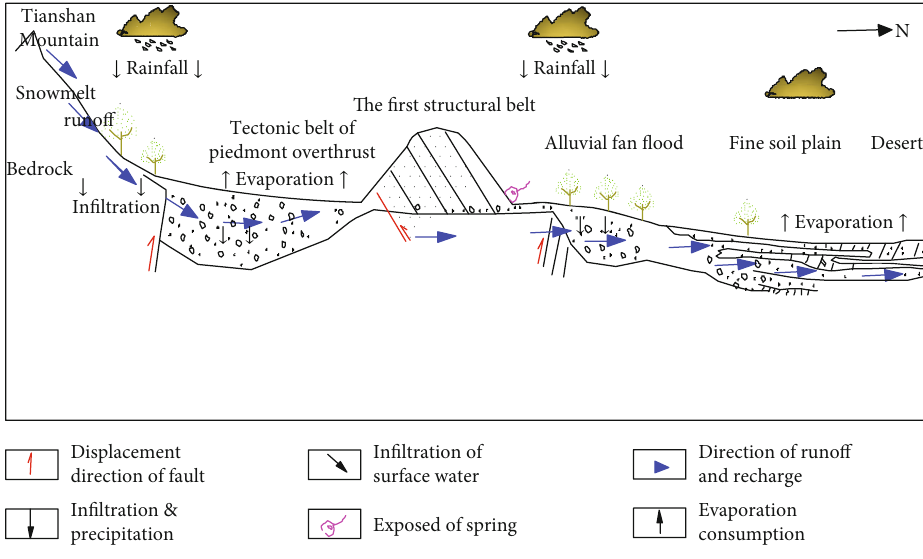
Figure 5: Cycle characteristics of water bearing H